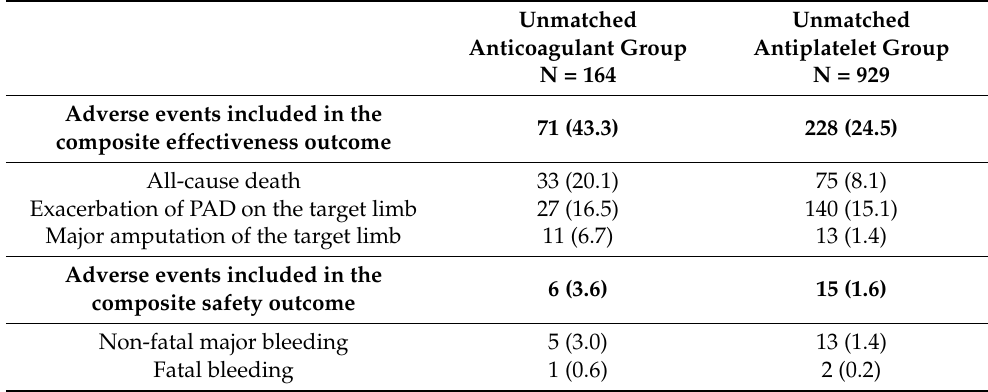
Table 3. Effectiveness and safety outcomes within the observed one-year period after revascularisa- tion for the group of patients treated with full-dose anticoagulant therapy and the group of patients treated with antiplatelet therapy, before propensity score matching.